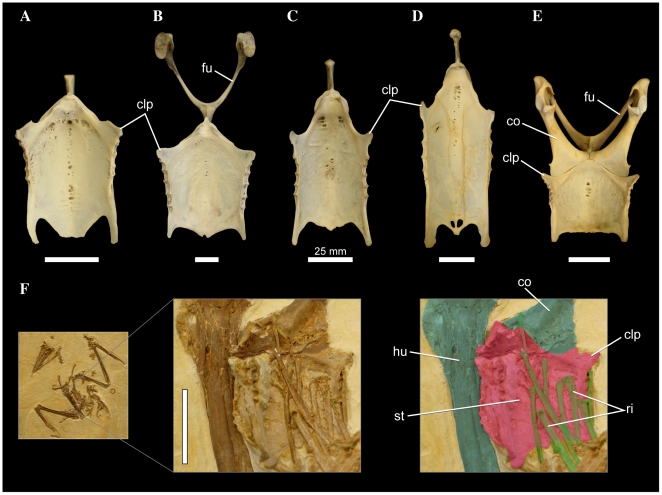
Sterna of several waterbird taxa.
Ciconia abdimii FMNH 368771 (A), Pelecanus erythrorhynchos FMNH 445082 (B), Sula sula FMNH 339372 (C), Morus serrator FMNH 339366 (D), Fregata minor FMNH 339421 (E), and Limnofregata azygosternon FMNH PA 755 (F), in dorsal (A–E), and dorsal and slightly left lateral (F) aspects. Individual elements are color-coded in (F). Scale bars equal 25 mm. Abbreviations: clp, craniolateral process; co, coracoid; fu, furcula; hu, humerus; ri, ribs; st, sternum.